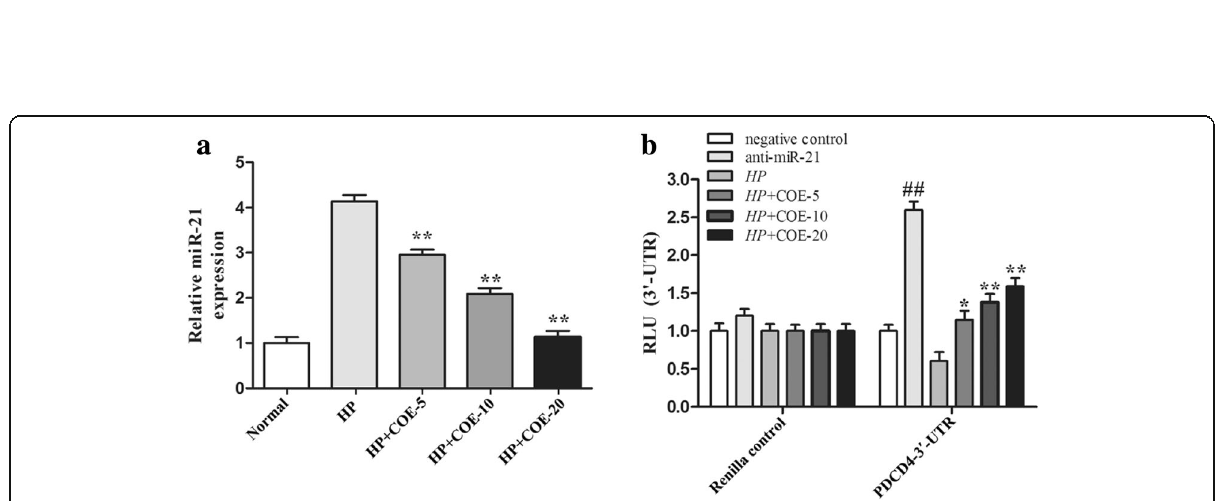
Fig. 5 COE inhibits H. pylori -induced miR-21 elevation and PDCD4 reduction. ( a ) GES-1 cells were treated by COE for 24 h after stimulating by H. pylori for 2 h. The miR-21 expression was quantitated by realtime-PCR. ( b ) COE ameliorates the H. pylori -induced inhibition of PDCD4 3 ′ -UTR reporter activity. GES-1 cells were transfected with renilla reporter construct (pGL3-PDCD4_3 ’ -UTR), miR-21 inhibitor (100 nM), negative control (100 nM), and pGL3-promoters and treated with H. pylori for 2 h in the presence of COE (20 μ g/mL). Cellular lysates were subjected to a luciferase reporter assay as described in Materials and Methods. The results are expressed as relative activity (relative luminescence units (RLU)) normalized to the luciferase activity in the vector control cells without treatment. Data presented in the bar graphs are the mean ± SD of three independent experiments. * P < 0.05, ** P < 0.01, compared to H. pylori infection-induced group. ## P < 0.01, compared to negative control